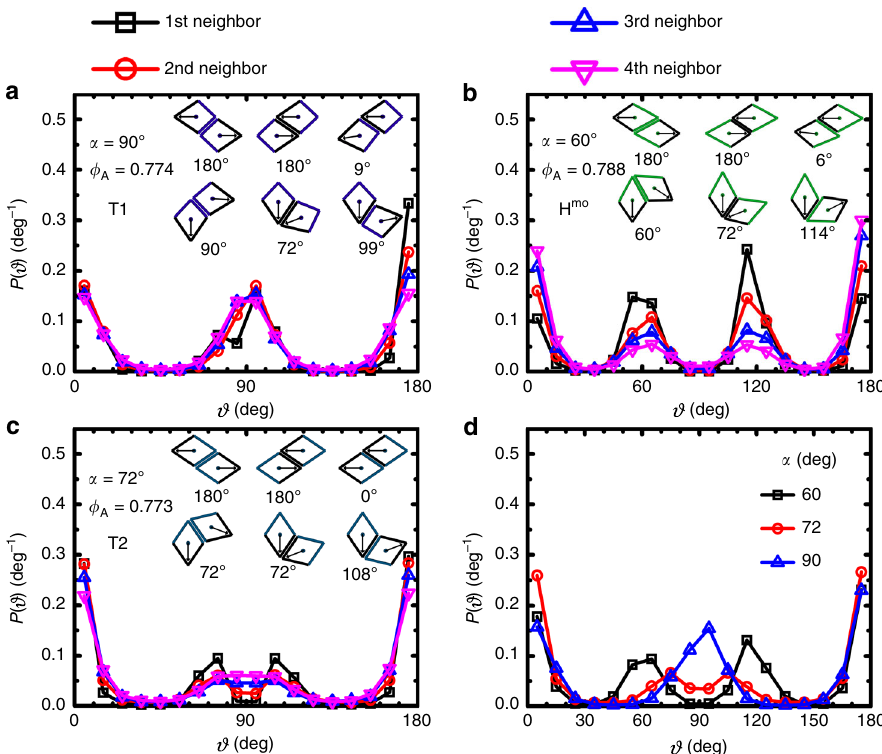
Fig. 5 Relative pointing angle distribution P ( ϑ ). a P ( ϑ ) in a tetratic phase T1. b P ( ϑ ) in a hexatic phase. c P ( ϑ ) in a tetratic phase T2. The distributions of the fi rst, second, third, and fourth nearest neighbors are shown. Insets illustrate LPC-NPPs with associated relative pointing angles for each type of kite. d P ( ϑ ) of the total four nearest neighbors for the three phases represented in a – c , clearly showing differences among the three